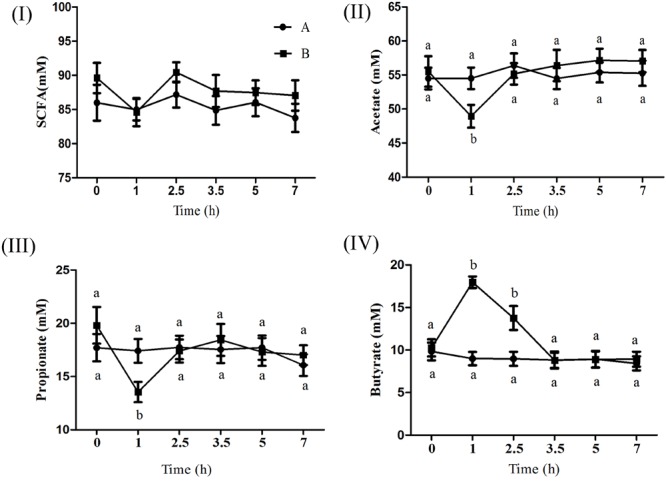
Effect of ruminal butyrate infusion on the molar concentration of total short chain fatty acids (I), acetate (II), propionate (III), and butyrate (IV) at 6 time points on day 14th of butyrate infusion. The goats were infused by 0.1 M potassium phosphate buffer (50 ml) with sodium butyrate at 0.3 (B = butyrate group, n = 12) or 0 (A = control group, n = 12) g/kg of BW per day for 28 days in the experimental duration. Values (means ± SE) differ if they do not share a common letter: a,bP < 0.05.